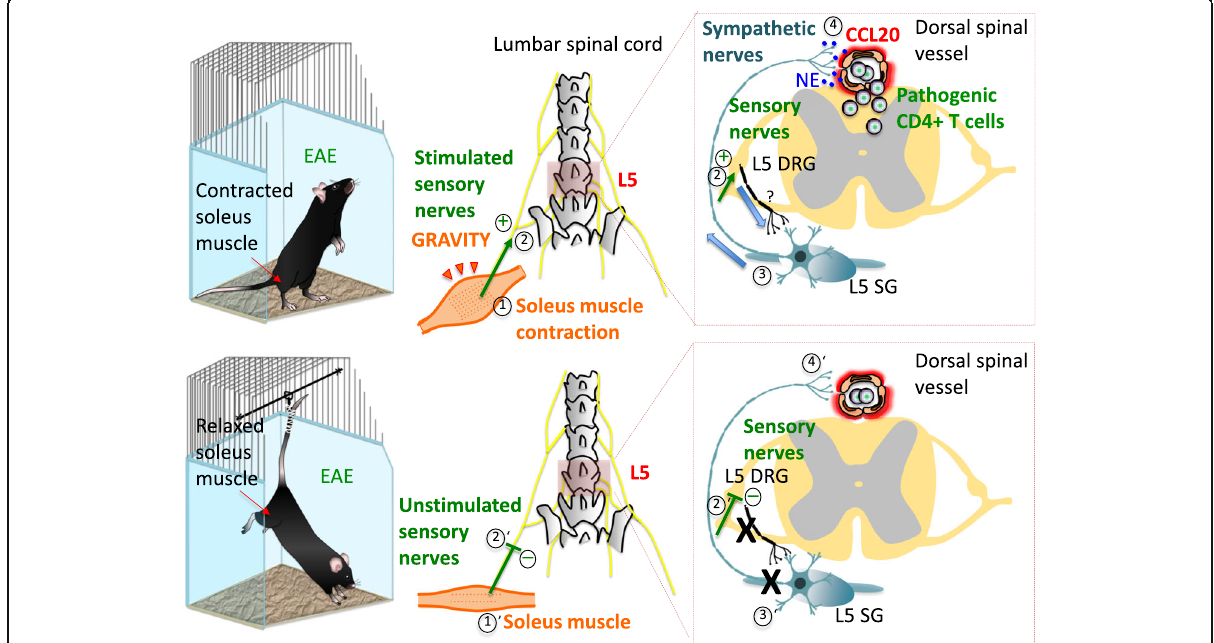
Fig. 1 Gravity gateway reflex. In free-moving mouse (upper panel) with adoptive-transfer EAE, pathogenic CD4+ T cells infiltrate the spinal cord parenchyma at the fifth lumbar (L5) level. This process is triggered by soleus muscle contraction (1) that counteracts gravity to maintain stability and body posture. Stimulated sensory nerves arising from the soleus muscle (2) and entering the L5 spinal cord through dorsal root stimulate sympathetic nerves (3) at the L5 spinal cord level via an unidentified neural circuit (?). This leads to chemokine expression including CCL20 in regional dorsal vessels of the spinal cord (4), establishing an immune cell gateway for migration of pathogenic CD4+ T cells across the BSCB. In tail-suspended mouse (lower panel) with adoptive-transfer EAE, soleus muscle relief from gravitational force (1 ’ ) prevents regional activation of sensory- (2 ’ ) and sympathetic-nerves (3 ’ ), and infiltration of pathogenic CD4+ T cells in the L5 spinal cord (4 ’ ). Abbreviations: EAE, experimental autoimmune encephalomyelitis; DRG, dorsal root ganglion; SG, sympathetic ganglion; NE, norepinephrine; BSCB, blood-spinal cord